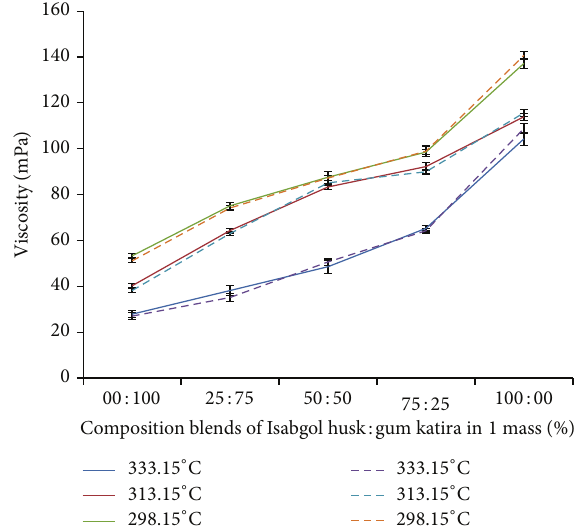
Figure 2: Comparative viscosity of blends determined experi- mentally (—) and by mathematical expressions ( ⋅⋅⋅ ) at 298.15 ∘ K, 313.15 ∘ K, and 333.15 ∘ K (the data used in the graph is the mean of three successive results ( 𝑛 = 3 ) and shown with error bars of